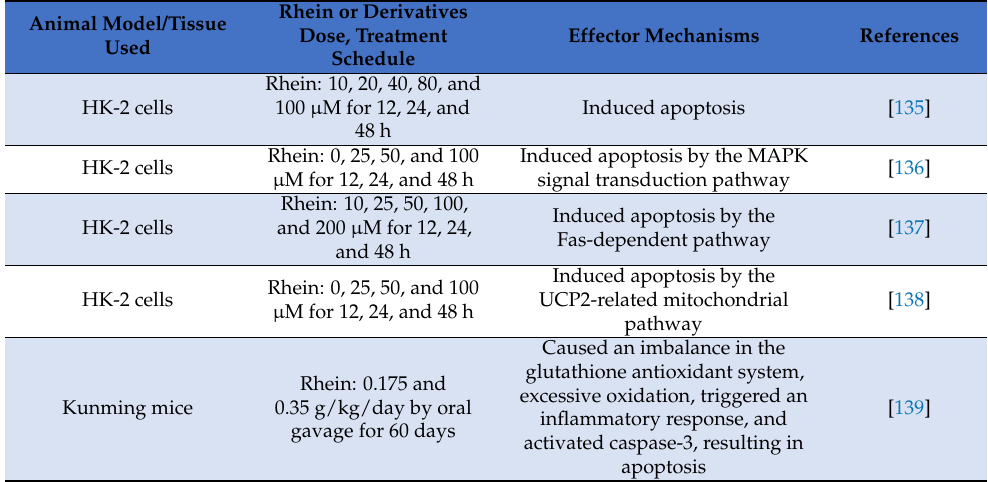
Table 2. Nephrotoxic effect of rhein and the related